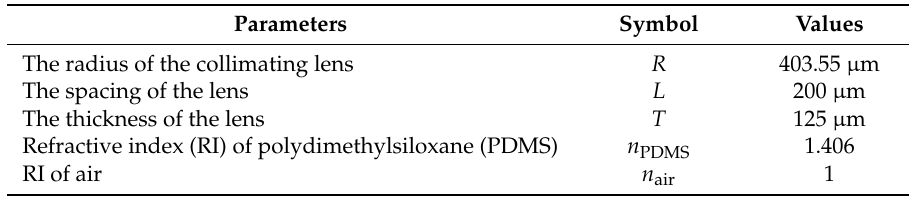
Table 1. Design parameters of the collimating lens.